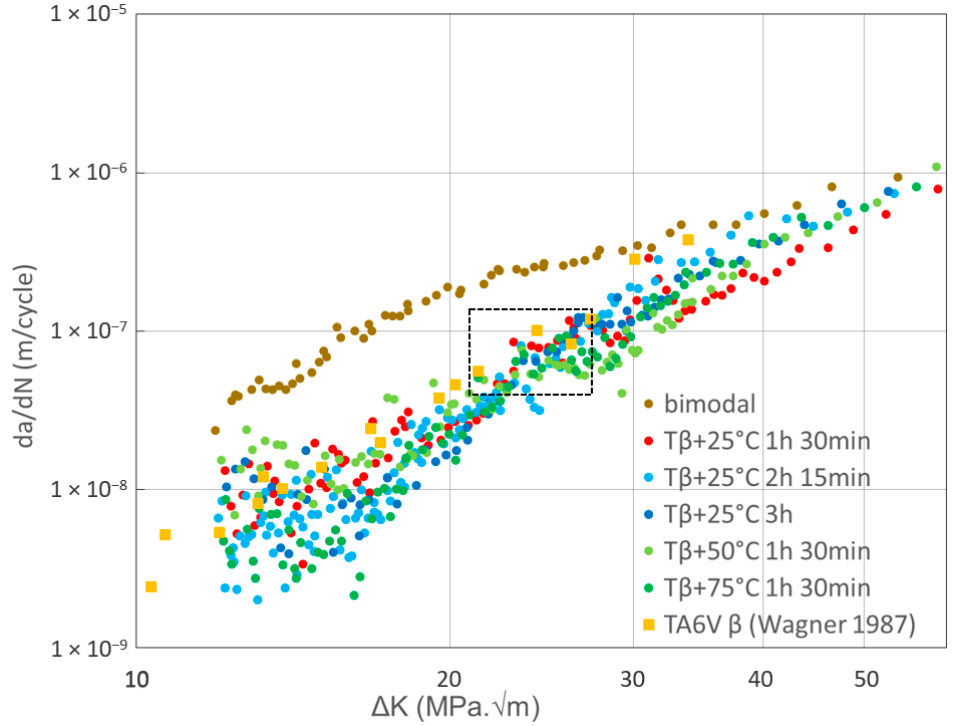
Figure 9. Crack propagation rates da/dN versus Δ K for the six different microstructures of Ti-6Al-4V ELI compared with the lamellar microstructure of standard Ti-6Al-4V, data from [13].